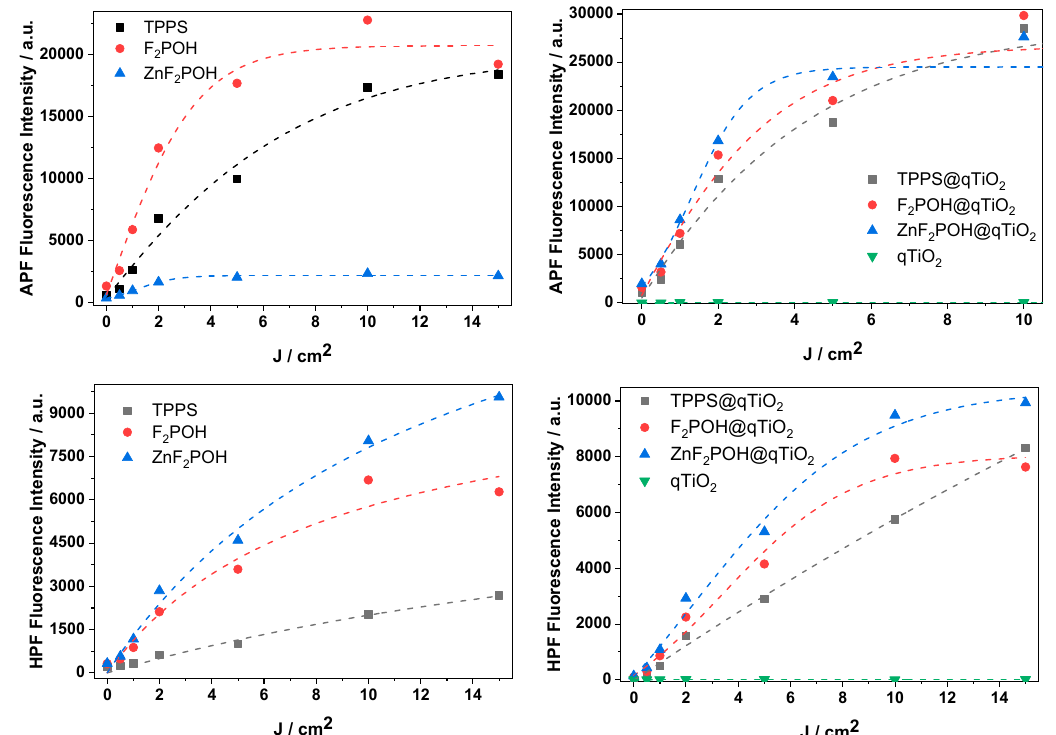
Figure 7 . Photogeneration of reactive oxygen species (ROS). Light dose-dependent increase of fluorescence of fluorescent probes (10 μ M): 3-p-(aminophenyl)fluorescein (APF), and 3-p-(hydroxyphenyl)fluorescein (HPF) in the presence of porphyrins and porphyrins at the surface of qTiO 2 materials irradiated with 420 ± 20 nm LED